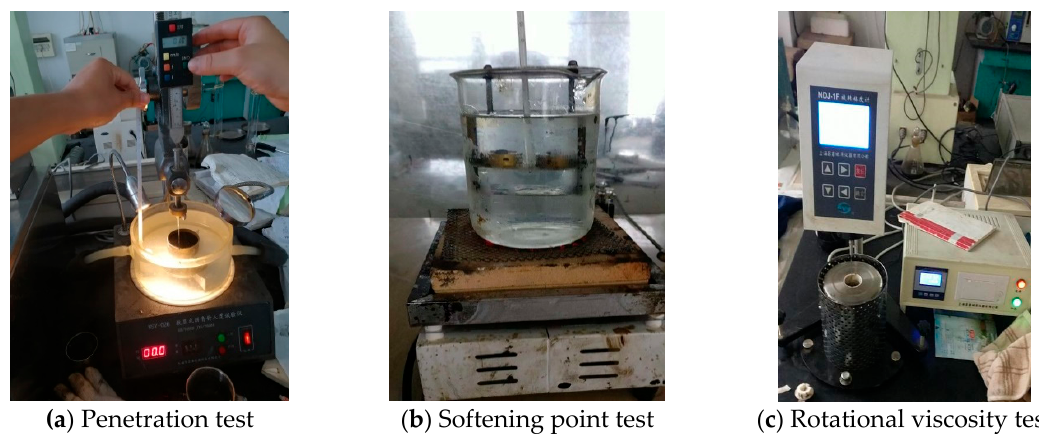
Figure 4. Basic physical properties tests of rejuvenated asphalt with WEO or WCO.